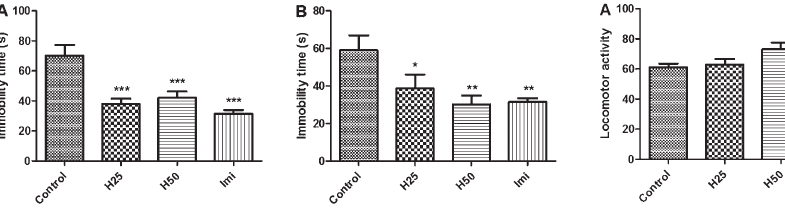
Figure 2. Locomotor activity in the open field test of mice that received saline vehicle (control), Hoodia gordonii [25 mg/kg (H25) and 50 mg/kg (H50), po ] and imipramine (IMI, 10 mg/kg, ip ). Animals received H. gordonii acutely ( A ) and for 15 consecutive days ( B ). Results are reported as means±SE. ***P , 0.001, compared to control (ANOVA and Student- Newman-Keuls post hoc